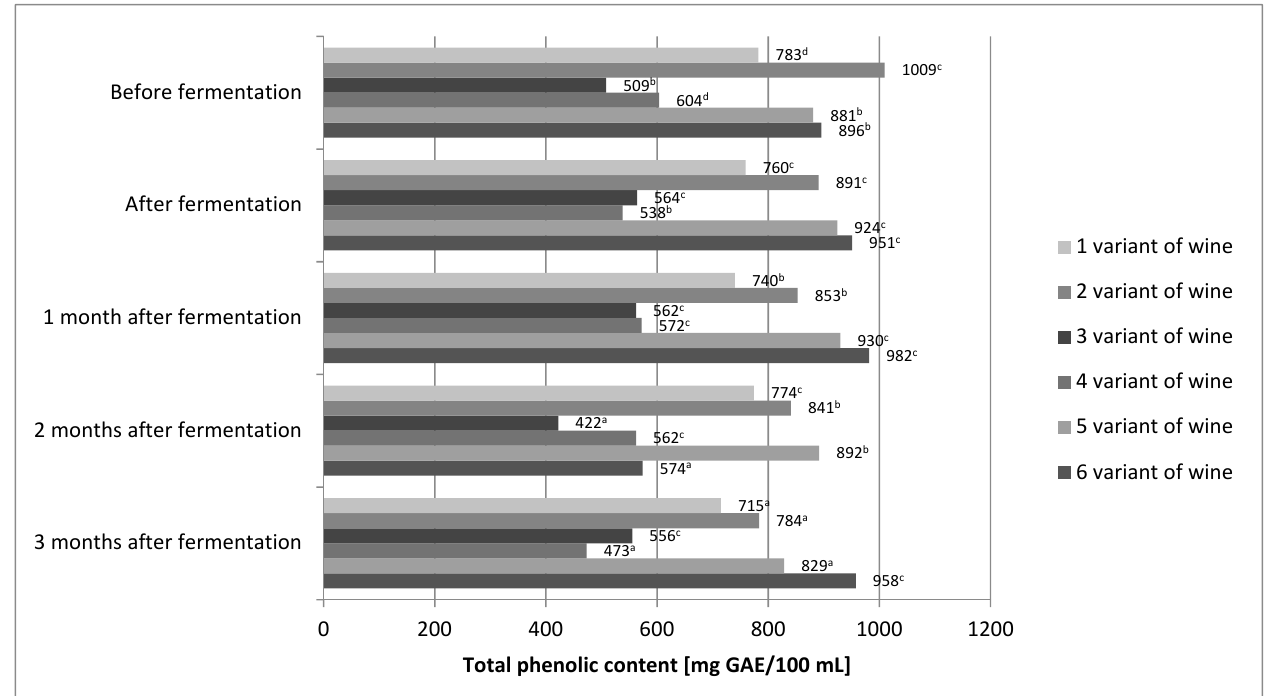
Figure 1. The concentration of polyphenols in different variants of wine prepared from fruits of Rosa rugosa . The values with different superscript letters are significantly different ( p < 0.05).